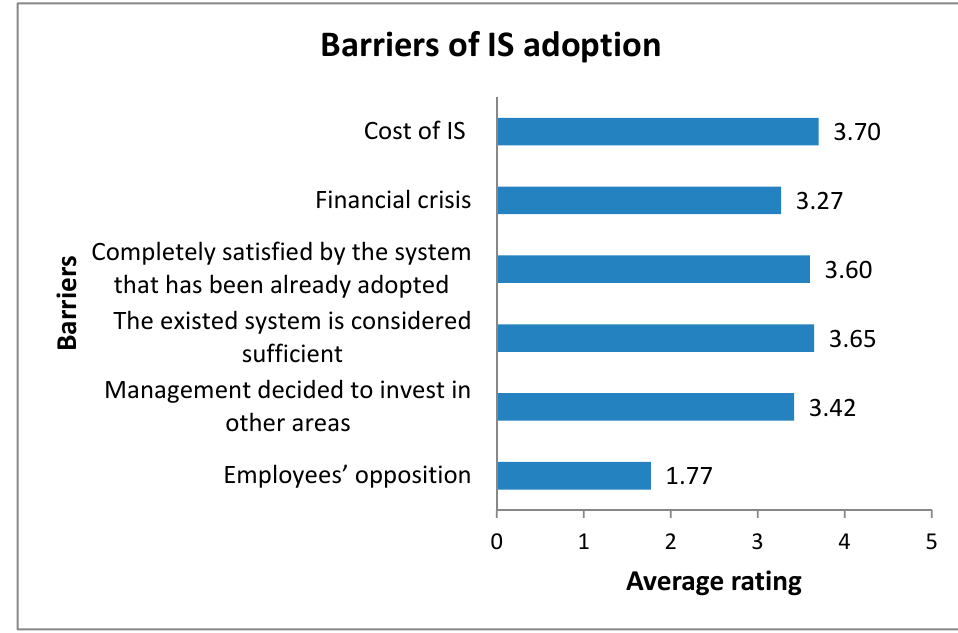
Figure 5. Barriers of IS adoption.